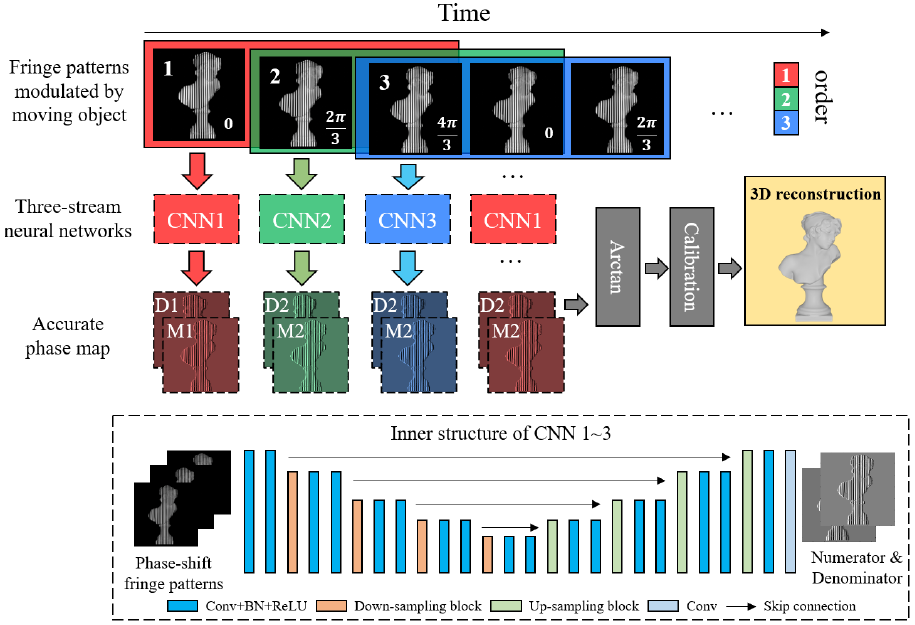
Figure 1. Proposed temporal three-stream neural networks-based method for motion-induced error compensation ( top ) and the inner structure of CNN1~3 ( bottom ).